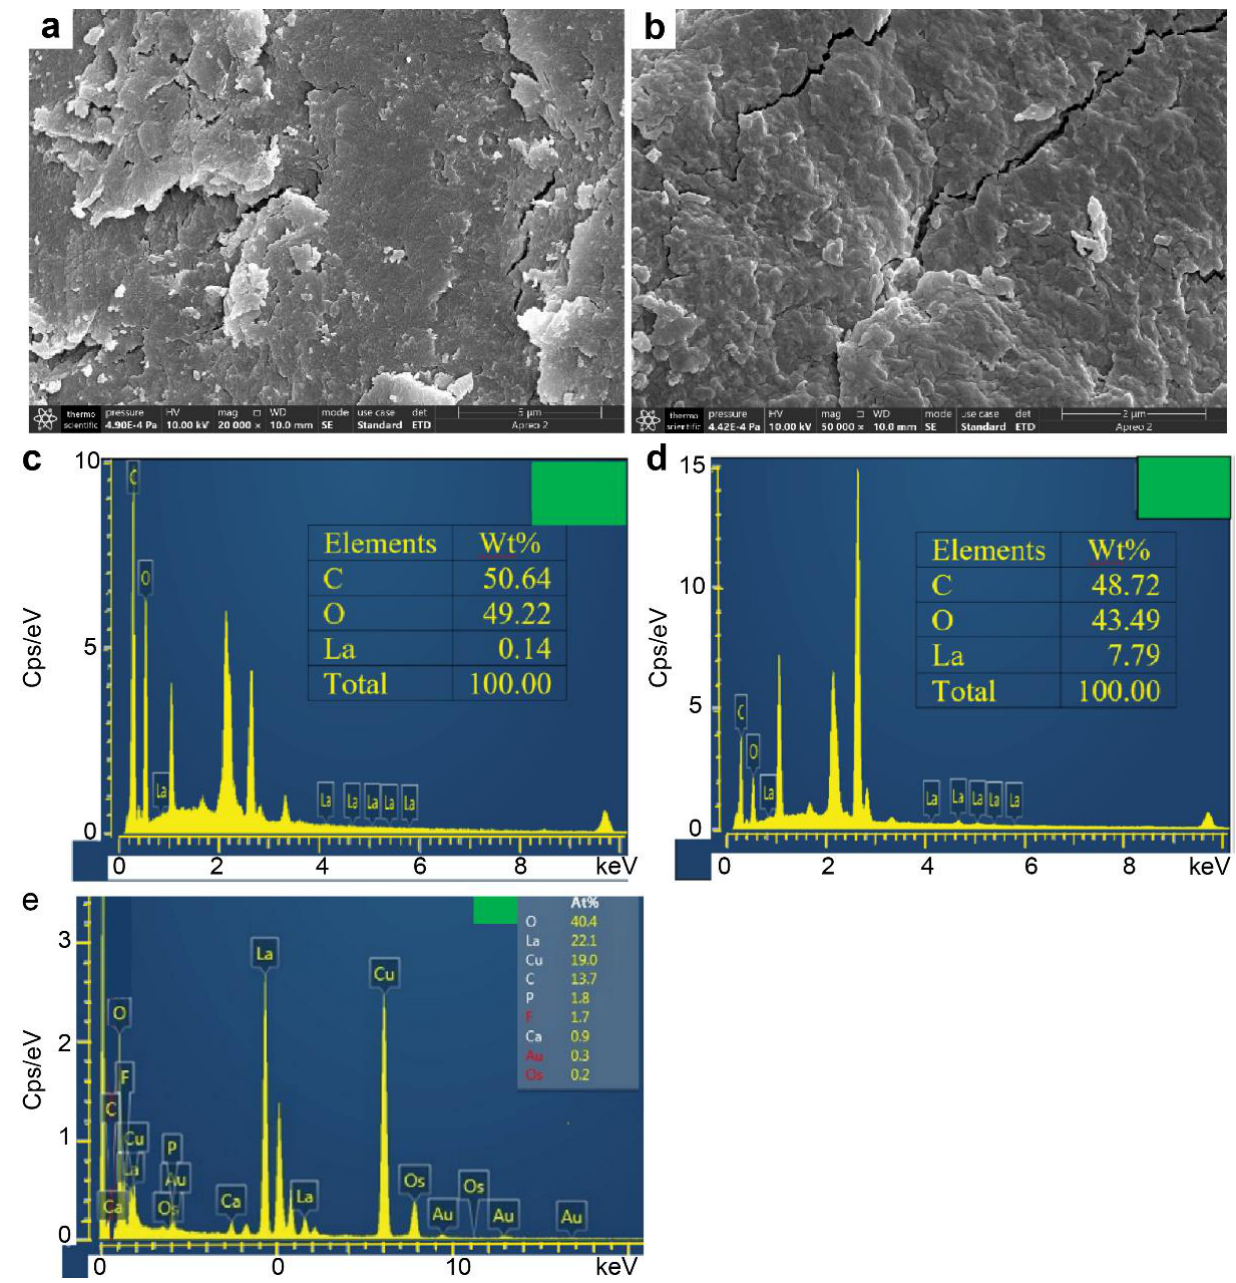
Figure 1. Scanning electron microscopy (SEM) images of agar ( a ) and agar – La ( b ); energy-dispersive spectroscopy (EDS) mapping of pure agar ( c ), agar – La ( d ), and agar – La-PO 43 − ( e ).